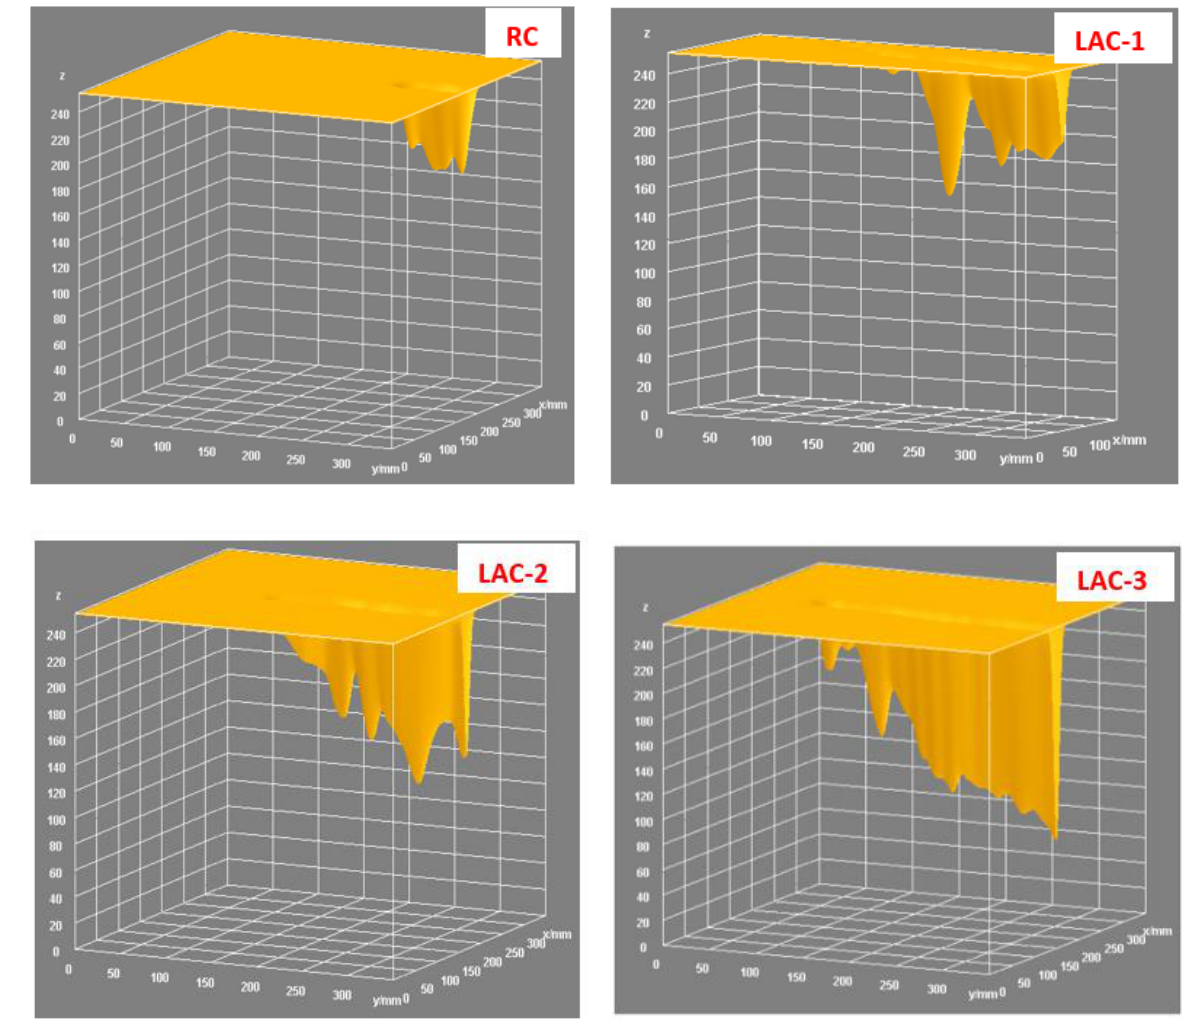
Figure 11. 3D surface plots of the fracture surfaces of the mixes.